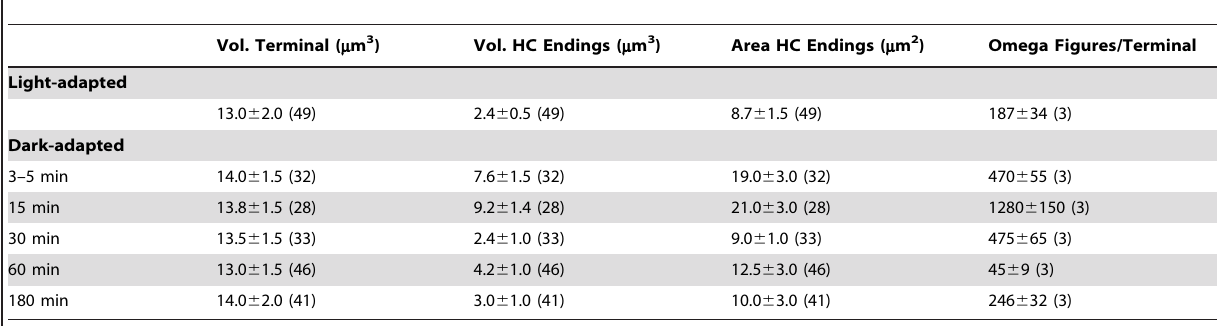
Table 2. Changes in rod spherules during dark